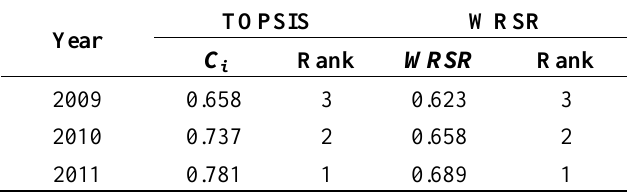
Table 6. Rankings for comprehensive performance evaluation of healthcare reform in Hubei Province